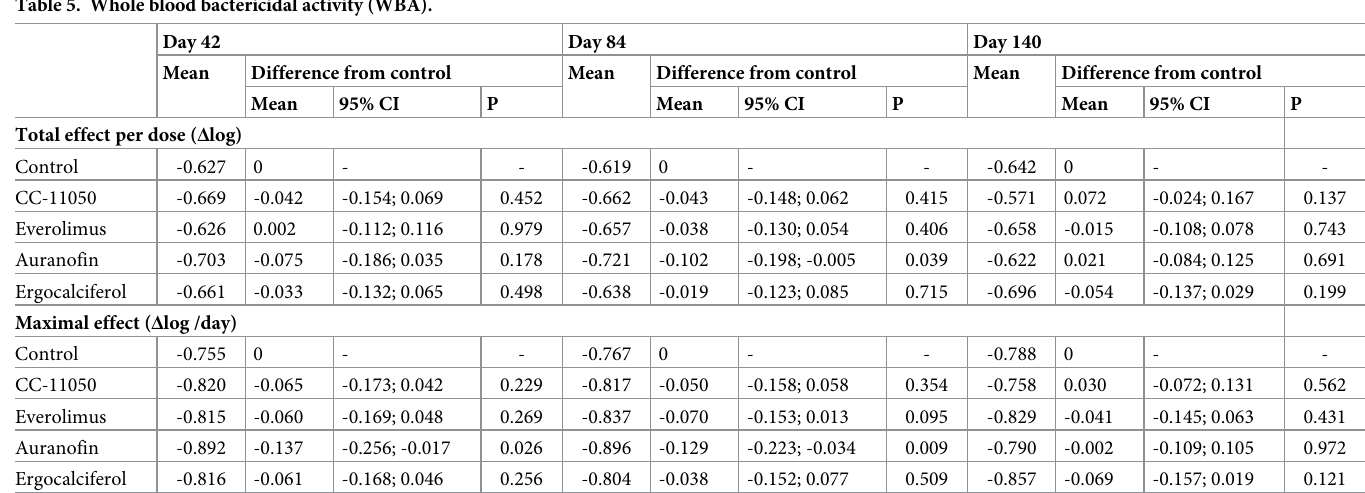
Table 5. Whole blood bactericidal activity (WBA).